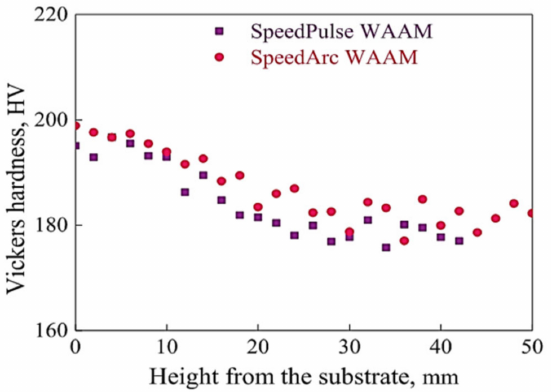
Figure 25. Hardness Characteristics. Reprinted with permission from Ref. [69]. Copyright 2019